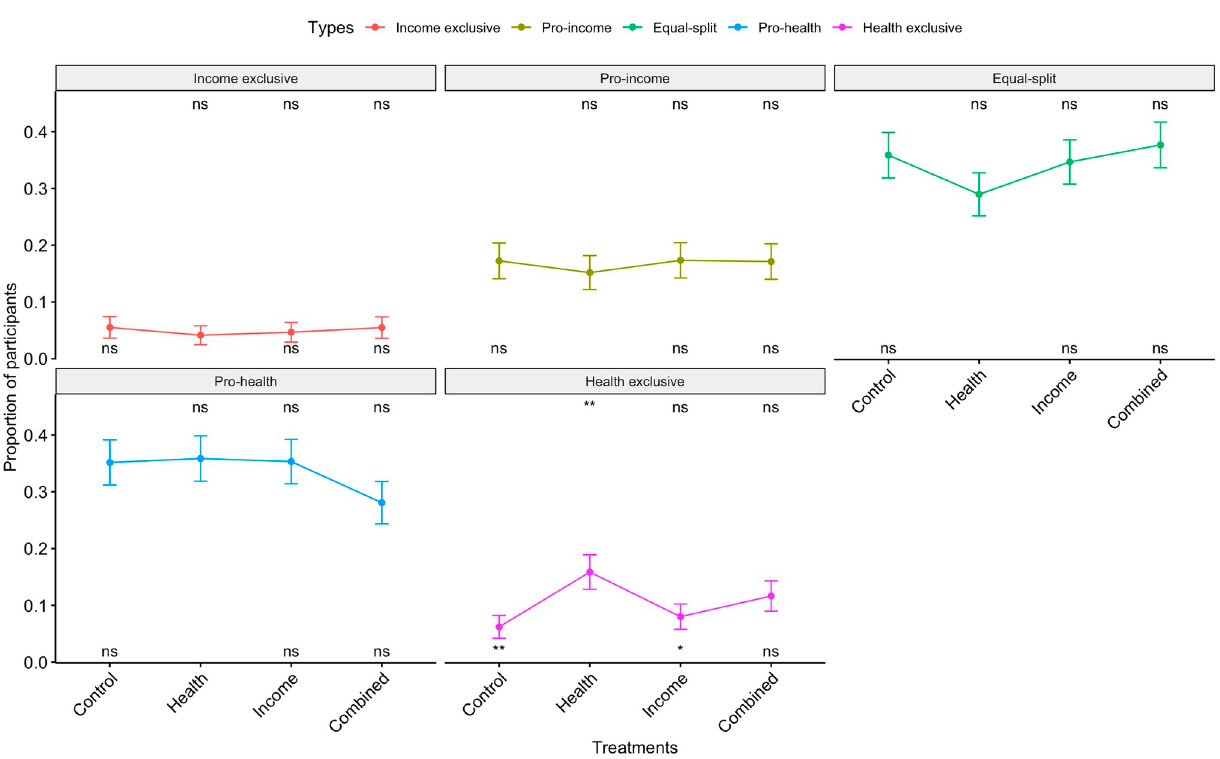
Fig 3. Proportion of participant types across the experimental conditions. The proportion of identified five types across the experimental conditions. � p < 0.1, �� p < 0.05, ��� p < 0.01.